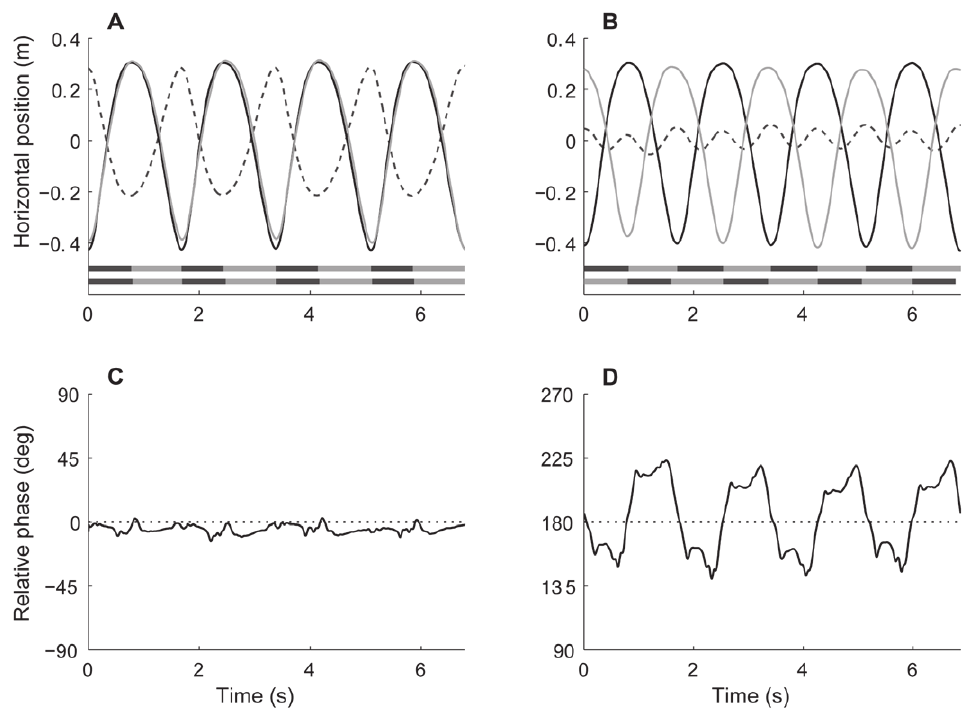
Figure 2. Interpersonal coordination. Top: an example of the center of mass (CoM) movement of two rowers (solid lines) and the movement of the ergometers (dashed line) during inphase (A) and antiphase rowing (B). The bars below the CoM movement indicate the duration of backward (cf. drive phase; dark grey) and forward (cf. recovery phase; light grey) CoM movement of both rowers. Bottom: continuous relative phase between the CoM movements during inphase (C) and antiphase rowing (D). The intended relative phase is displayed by the dotted